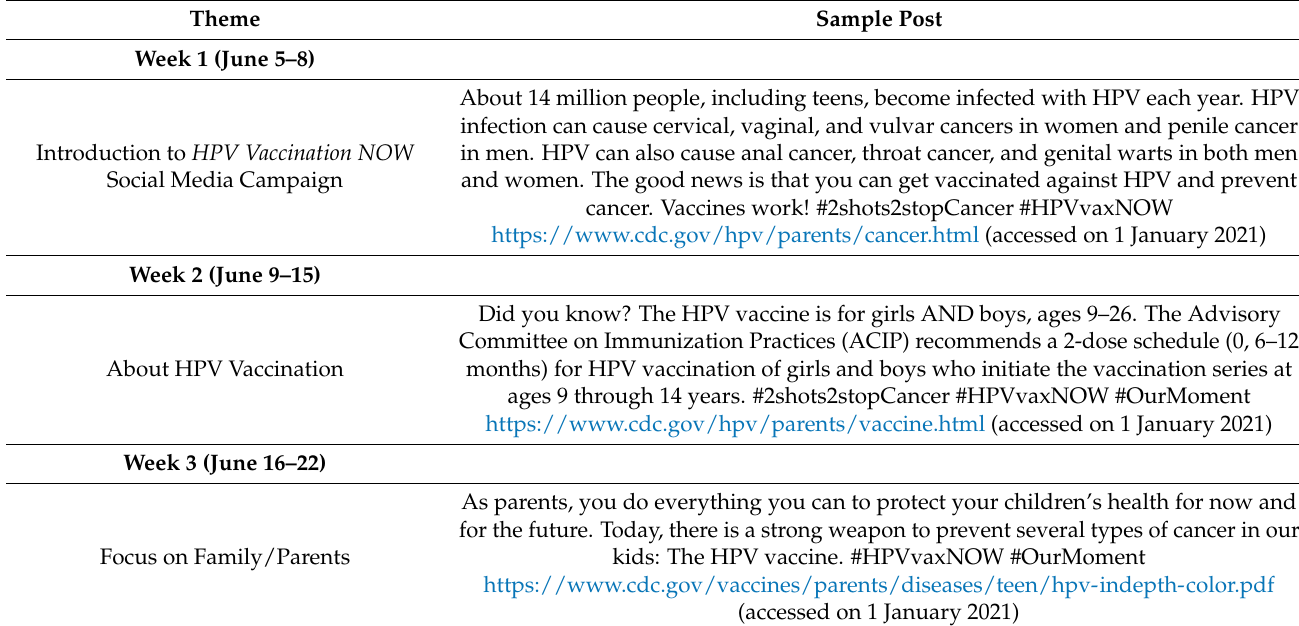
Table 1. Editorial calendar with sample social media